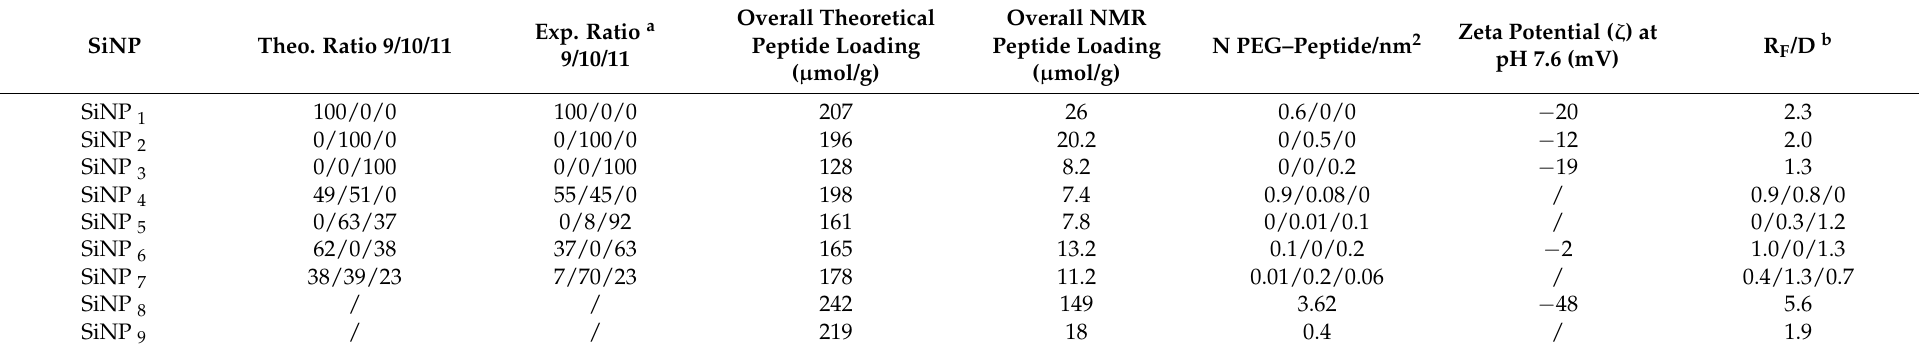
Table 4. Relative and quantitative integration of 19 F NMR signals of NPs grafted with PEG–peptides 9 , 10 , and 11 , and negative control (PEG and PEG–peptide 12